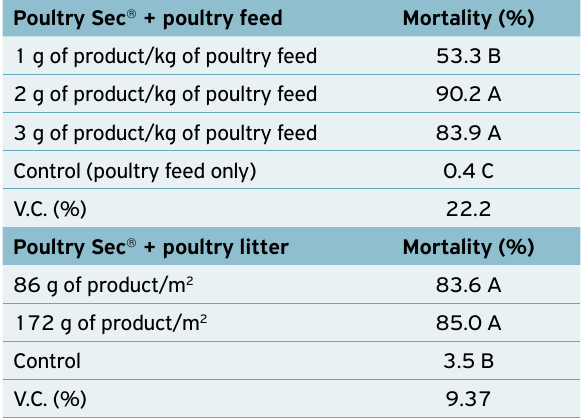
Table 1. Mortality (%) of lesser mealworm adults that had contact with different dosages of DE in the two application strategies (poultry feed and poultry litter), 10 days after treatment (26ºC, 12 h photophase).